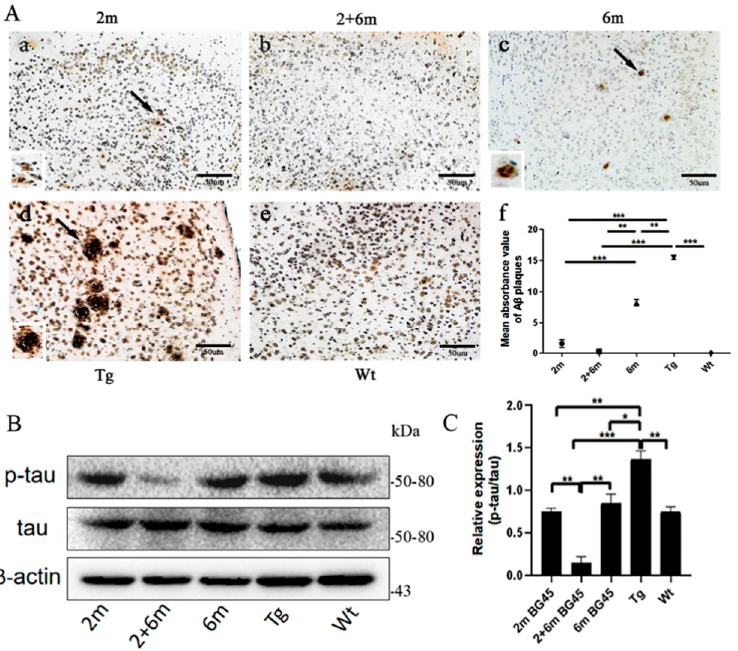
Figure 5. BG45 reduced A β deposition and downregulated p-tau expression in the entorhinal cortexes of the APP/PS1 mice. ( Aa – e ) Representative photographs of A β deposition in the entorhinal cortex samples. ( Af ) Quantitative statistical analysis of A β density. ( B ) Representative protein expression bands of p-tau and tau. ( C ) Quantitative statistical analysis of p-tau and tau. All values are presented as the means ± SDs from three independent experiments. *** p < 0.001, ** p < 0.01, and * p < 0.05. n = five mice per group.